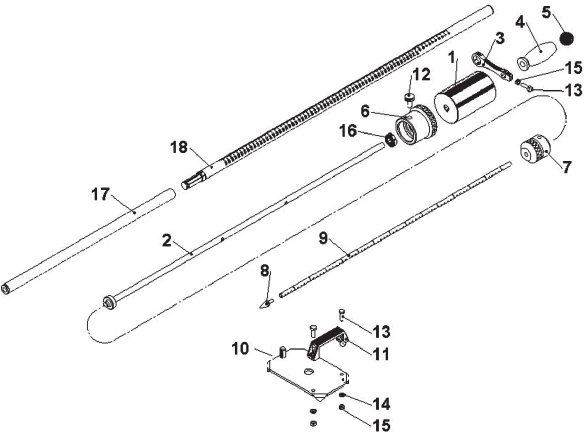
Figura 4. Catálogo de peças, contendo 18 componentes do penetrômetro de impacto. Obs.: Modificações: argola de nível de leitura (3); inclusão, na chapa (10) de nivelamento, de um parafuso para fixar a base da régua (17), que por sua vez se conecta à régua propriamente dita através de imã